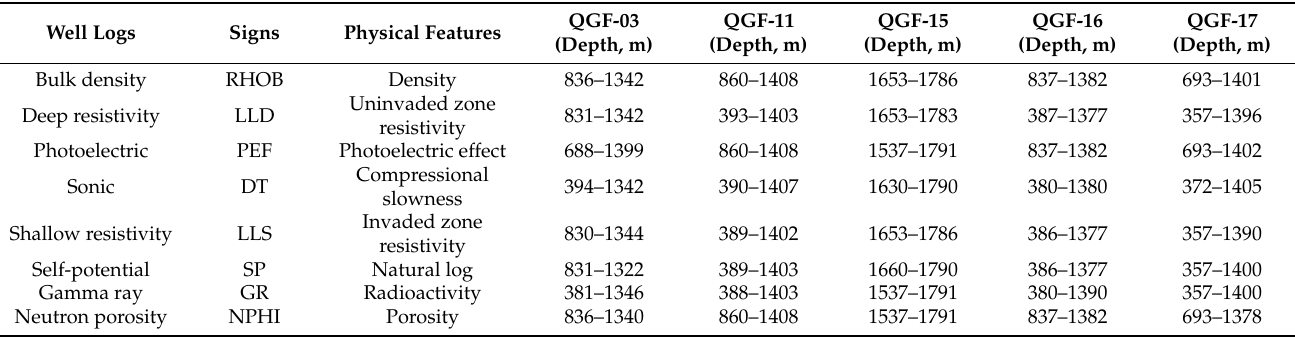
Table 1. The data obtained within geophysical logs.